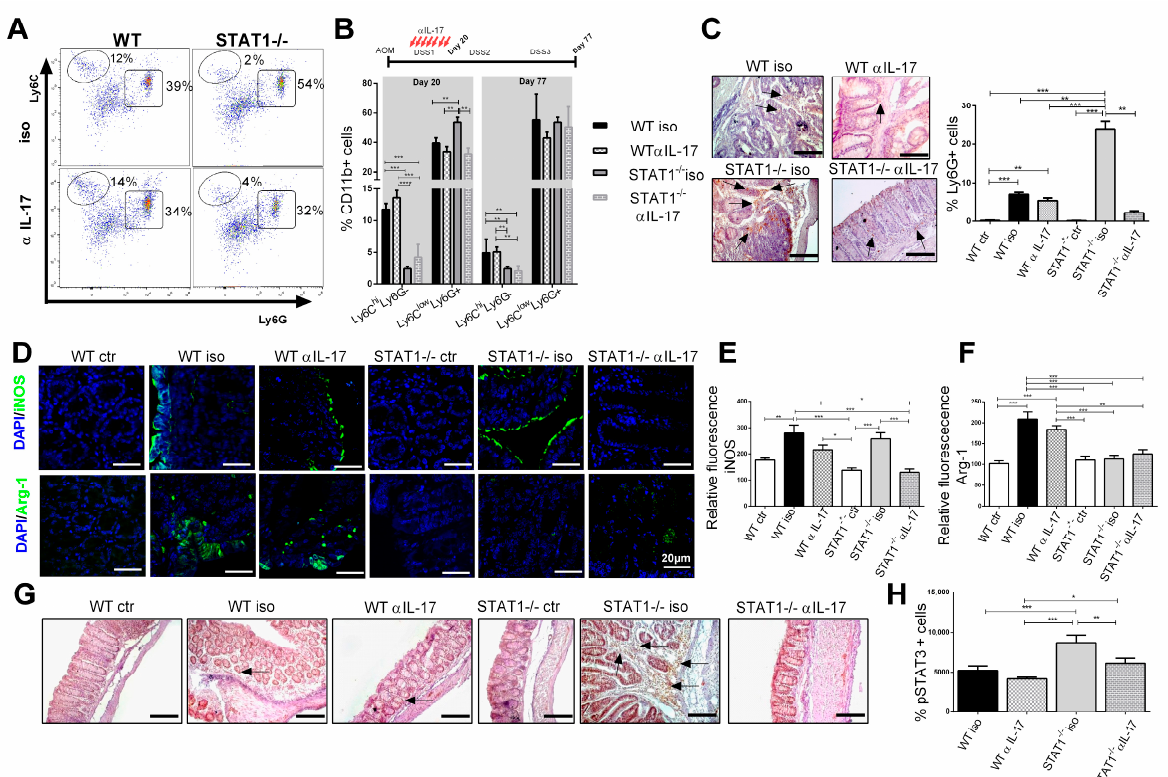
Figure 4. Anti-IL-17 treatment affects the recruitment of neutrophils and CD11b+Ly6C low Ly6G+ cell populations in STAT1 -/- mice. Mice were treated as in Figure 3A. Circulating cells were obtained from tumor-bearing WT or STAT1 -/- mice treated with anti-IL-17( α IL-17) or isotype (iso) antibodies. ( A ) representative flow cytometry plots are shown with Ly6C and Ly6G markers of gated living CD11b+ population cells in blood; ( B ) the bar graph illustrates the frequencies of CD11b+Ly6C hi Ly6G-and CD11b+Ly6C low Ly6G+ cell populations in blood at the indicated time intervals (day 20 and day 77), gated as in Figure 4A; ( C ) representative immunohistochemical staining of Ly6G in colon tissue at day 77. The arrowheads indicate Ly6G localization. Scale bars: 50 µ m; ( D ) confocal representatives merged images of the immunofluorescence staining of the distal/affected colon tissue at day 77 using an anti-iNOS antibody (green) or anti-Arginase-1 antibody (green) and DAPI (blue) counterstaining. The images were captured in a confocal microscope at 63X. Scale bars = 20 µ m. Relative fluorescence for iNOS ( E ) and Arginase-1 ( F ); ( G ) representative immunohistochemical staining of phosphorylated